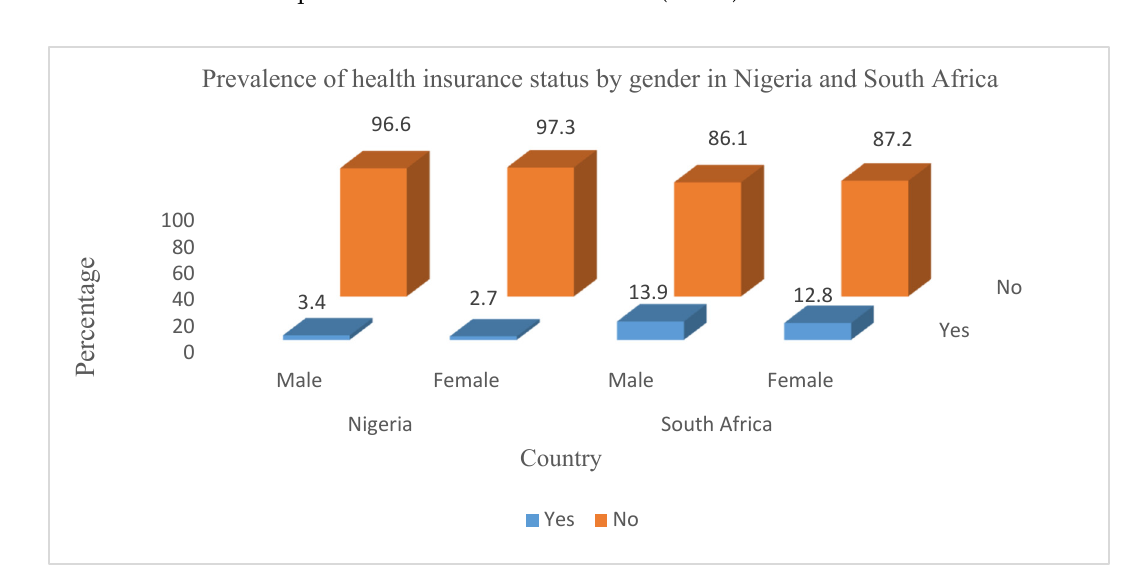
Figure 2. Distribution of health insurance status by gender in Nigeria and South Africa.